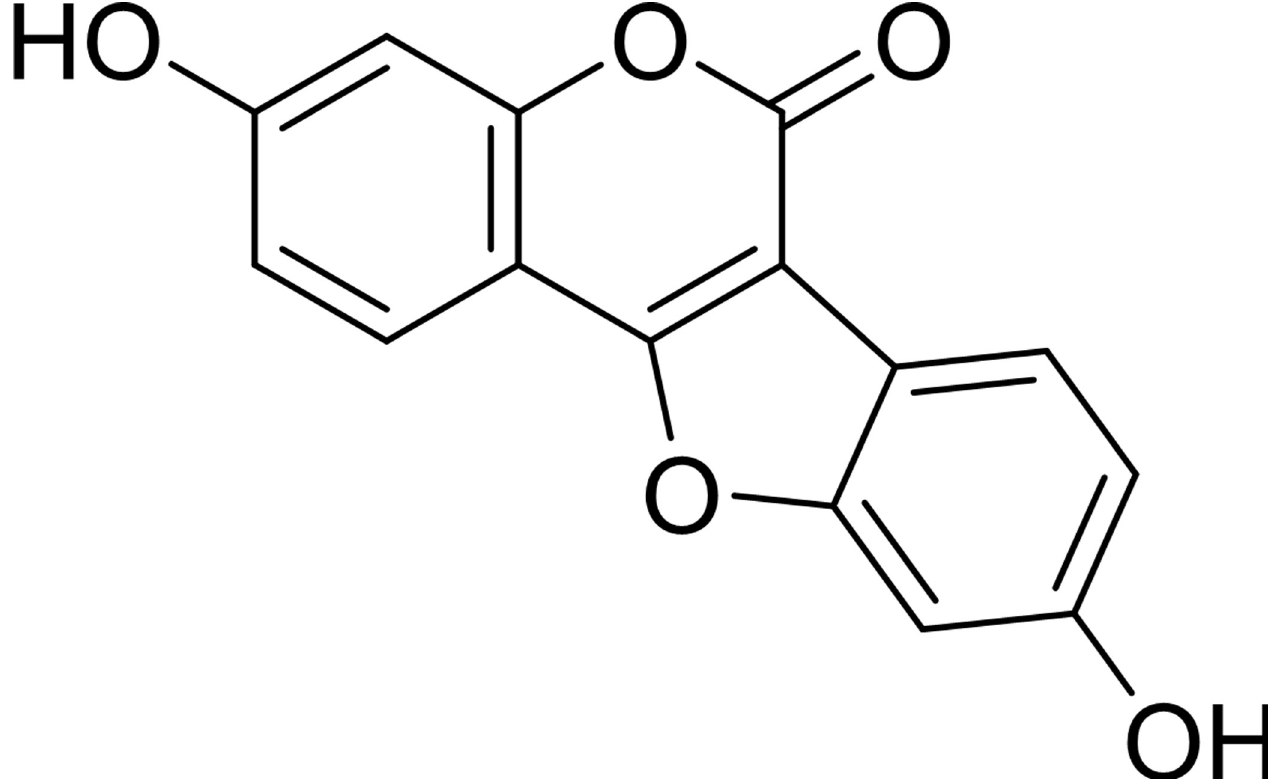
Fig 1. Chemical structure of